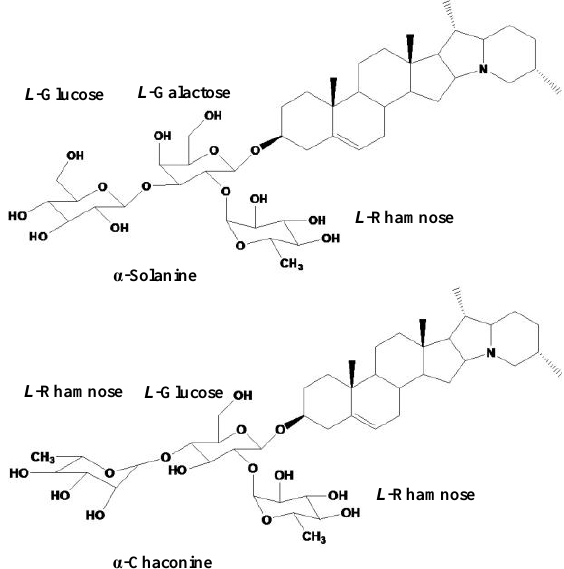
Figure 1. Structures of α-solanine and